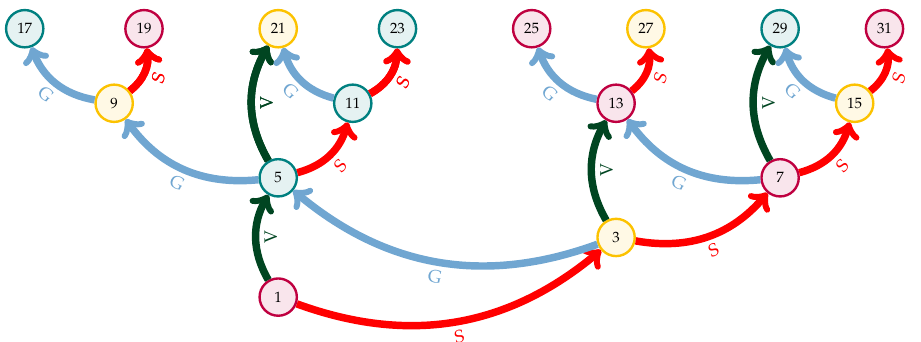
Figure 2. Quiver connecting all odd numbers from 1 to 31 with the arrows of actions S, V, and G. The set 2 N ∗ + 1 is thus endowed with three unary operations without a general inverse that are noncommutative with G S = V . Whenever we mention the inverse of these operations, we ◦